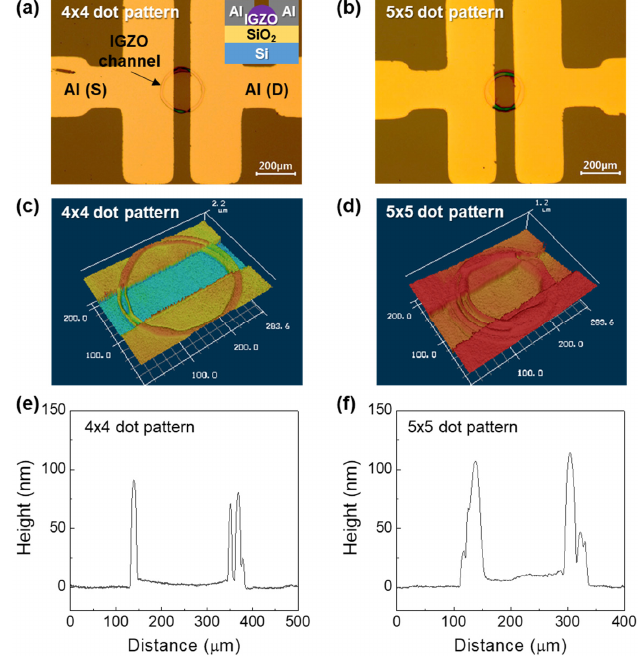
Figure 2. Optical microscope images of inkjet-printed IGZO thin-film transistors (TFTs) printed by ( a ) 4 × 4, and ( b ) 5 × 5 dot array patterns. The inset in ( a ) shows the schematic device structure of an IGZO TFT with SiO 2 gate dielectric. Confocal microscope images of inkjet-printed IGZO channel layer printed by ( c ) 4 × 4, and ( d ) 5 × 5 dot array patterns. Thickness profiles of inkjet-printed IGZO channel layer printed by ( e ) 4 × 4, and ( f ) 5 × 5 dot array patterns.